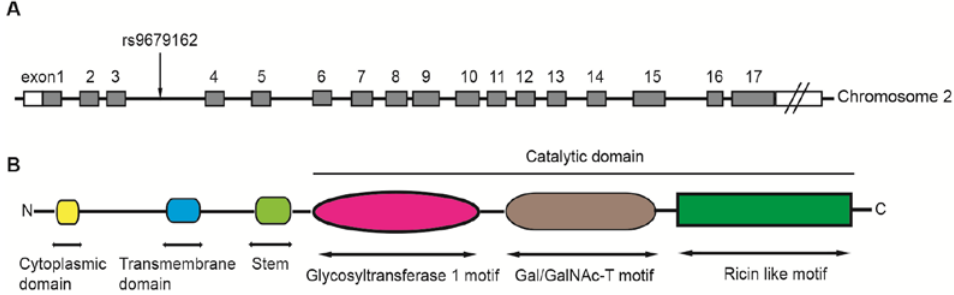
Figure 1. The structure of the GALNT14 gene, including the location of rs9679162 ( A ), and the common functional domains of GALNT proteins ( B ). The GALNT14 gene is located on chromosome 2 and includes at least 17 exons. rs9679162 is located between exons 3 and 4 ( A ). The members of the GALNT family possess several common functional domains ( B ). The N-terminal cytoplasmic domain contains 4 to 22 amino acids. The transmembrane domain contains 15 to 25 amino acids. The catalytic region contains more than 450 amino acids, which can be divided into three parts: a glycosyltransferase 1 motif, a Gal / GalNAc-T motif, and a ricin like motif.